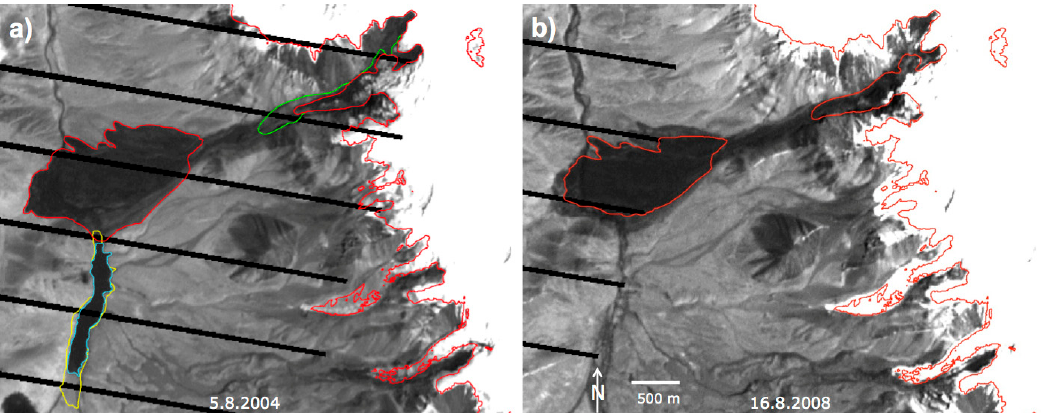
Figure A2. Landsat 7 ETM+ scenes (pan band) used to mark the extent of the deposits. ( a ) Scene from 5 August 2004 (green: maximum glacier extent before the 2004 collapse, red: extent of the deposit, light blue/yellow: lake extent from 5 August/14 September 2004. ( b ) Scene from 16 August 2008 (after the 2007 collapse) showing the new deposit in red. Image source: